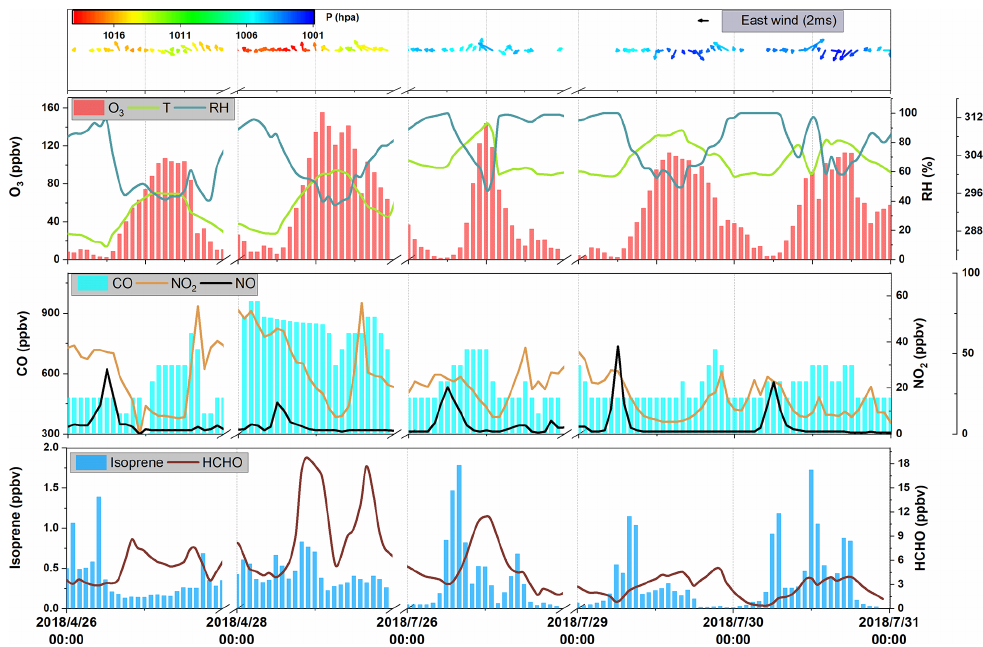
Figure 2. Time series of hourly averages for O 3 , CO, NO, NO 2 , isoprene, HCHO, and meteorological parameters.